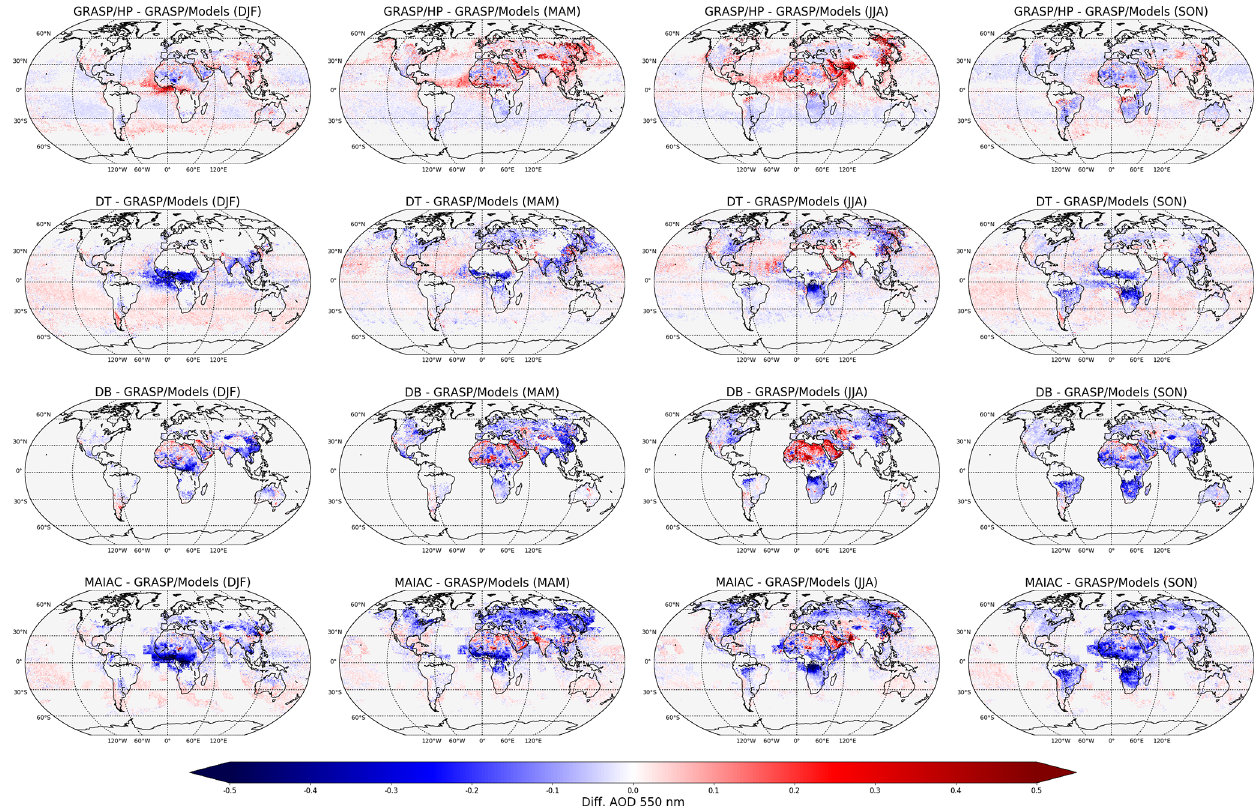
Figure 22. Spatial distribution of 0.1 ◦ × 0.1 ◦ seasonal AOD (550nm) differences between PARASOL and MODIS aerosol products, refer- enced to